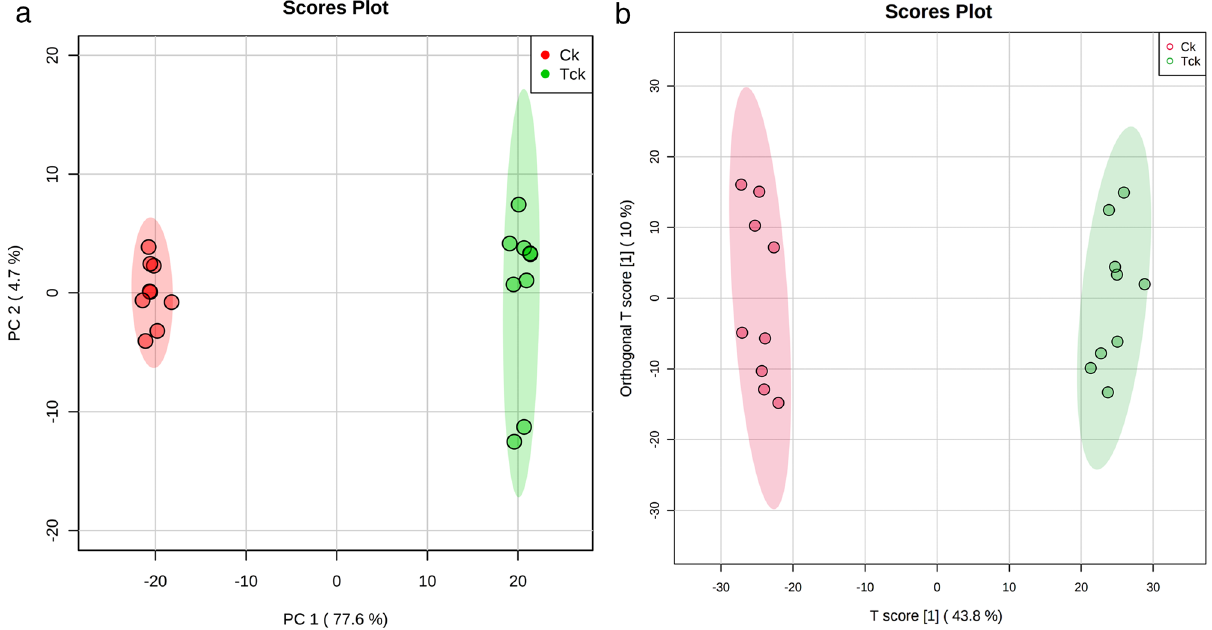
Figure 2. PCA and OPLS-DA analysis of T. controversa -infected and noninfected samples. ( a ) PCA of T. controversa -infected and noninfected samples. ( b ) OPLS-DA analysis (Q = 0.938). Ck stands for noninfected samples, while Tck stands for T. controversa -infected